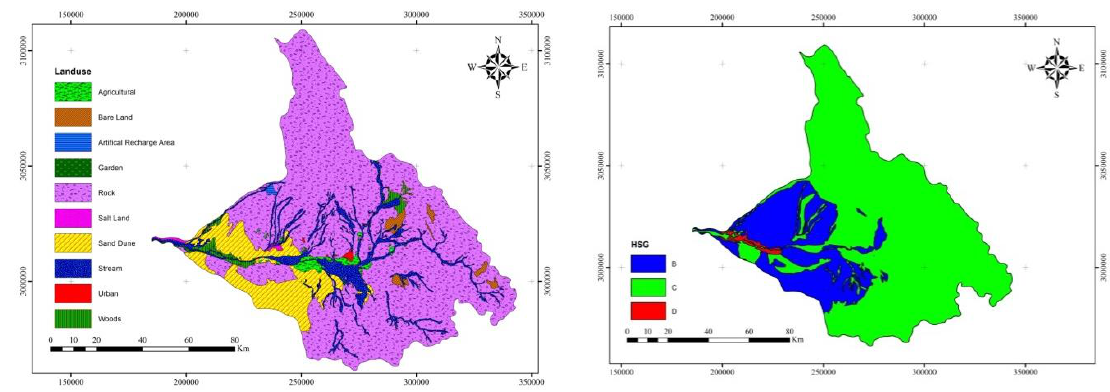
Figure 8. Soil hydrology groups of Iranshahr catchment